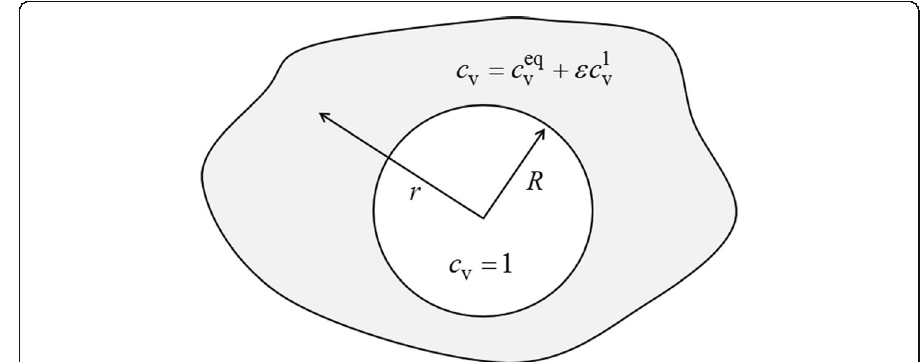
Fig. 2 A schematic illustration of a spherical void growing in a solid matrix with a uniform low supersaturation (low driving force limit of model